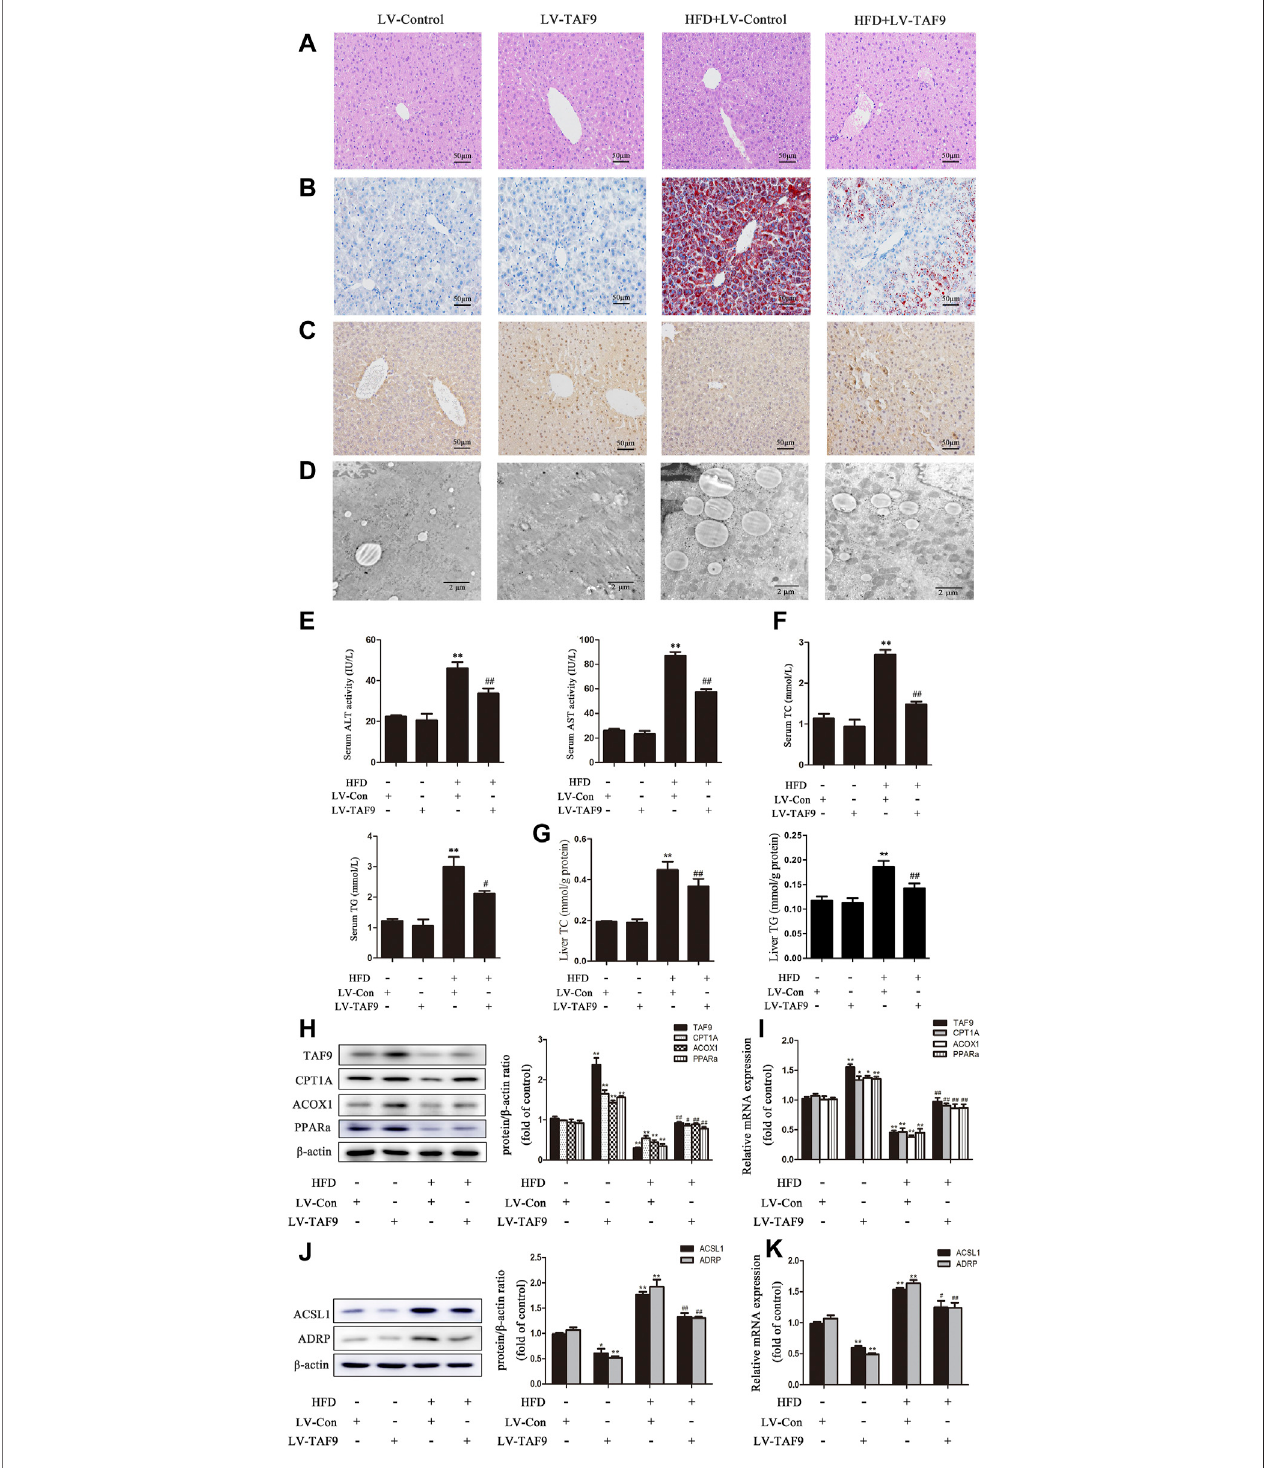
FIGURE 5 | TAF9 overexpression attenuates HFD-induced fatty acid β -oxidation reduction and LD accumulation in mice. TAF9 overexpression was induced via lentiviruses delivered to C57BL/6 mice fed a HFD. (A,B) H&E-stained and Oil Red O-stained images of liver sections were taken at 400 × magni fi cation. (C) Images of TAF9 IHC staining of liver sections were taken at 400 × magni fi cation. (D) Electron microscopy images of liver sections were taken at 12000 × magni fi cation. (E) Serum levels of ALT and AST ( n (cid:2) 6). (F) Serum levels of TC and TG ( n (cid:2) 6). (G) Liver levels of TC and TG ( n (cid:2) 6). (H – K) Protein ( n (cid:2) 3) and mRNA ( n (cid:2) 6) levels of fatty acid β -oxidation-related genes (CPT1A, ACOX1 and PPAR α ) and LD accumulation-related genes (ACSL1 and ADRP) in the liver. * p < 0.05, ** p < 0.01 vs. the LV-control group; # p < 0.05, ## p < 0.01 vs. the HFD group.